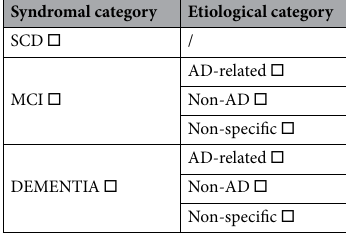
Table 1. Request form.